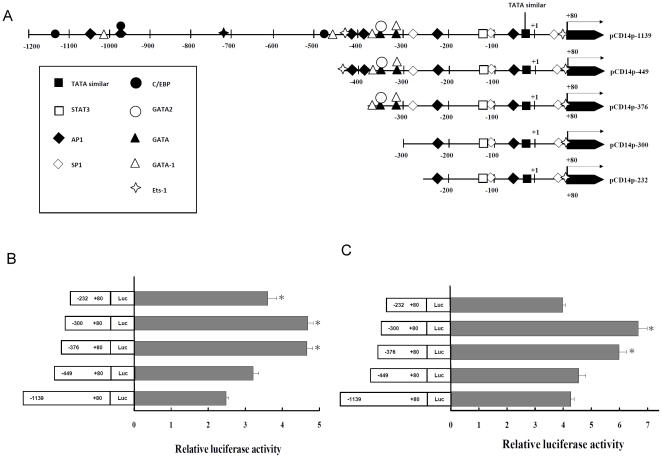
Deletional analysis of the CD14 promoter.(A) Schematic representation of CD14 deletional constructs. A series of 5′-deletional segments was generated by inserting into the multiple cloning sites upstream the luciferase reporter gene in a promoterless and enhancerless vector, pGL3. Transient transfection in (B) C9 rat hepatocytes and (C) HSC-T6 cells. Cells were transiently transfected with the constructs described in (A). Luciferase activity was measured 24 h after transfection. The promoter activity of each construct is calculated relative to the activity of the pGL3 vector. Data shown are mean±S.E. of five independent experiments with triplicate samples used in each experiment (*indicates P<0.05 relative to pCD14p−1139).